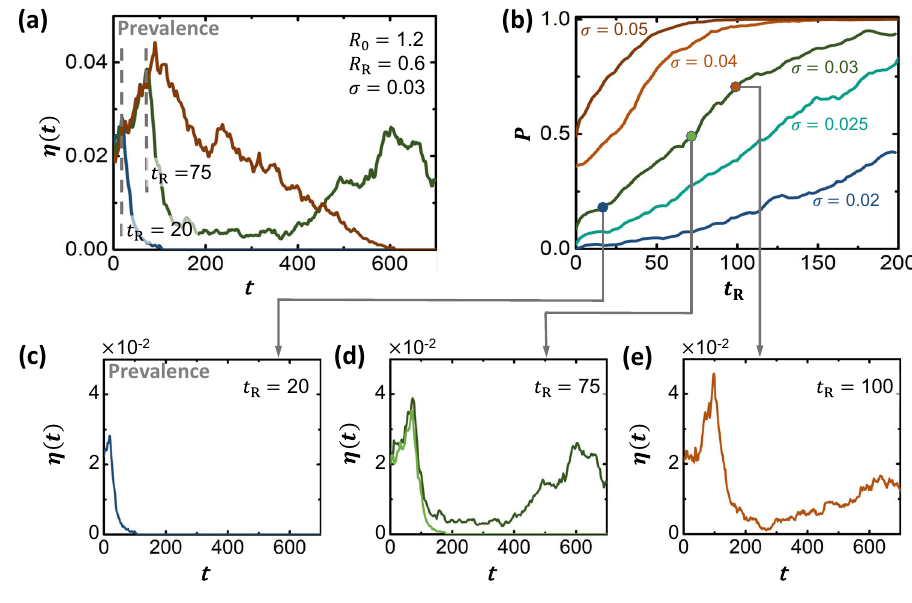
Fig.4|Timingourmitigation.a Theprevalence η ( t )vs. t withoutmitigation(red), under early mitigation (blue, t R =20) and under late mitigation (green, t R =75). Startingfrom R 0 =1.2, σ =0.03,themitigationreduces R 0 to R R =0.6,afactorofone half. While early mitigation ensures the elimination of the pathogen (blue), under late mitigation (green), the initial decline is eventually reversed due to the appearance of a critical mutation. Note that for evolving pathogens the late